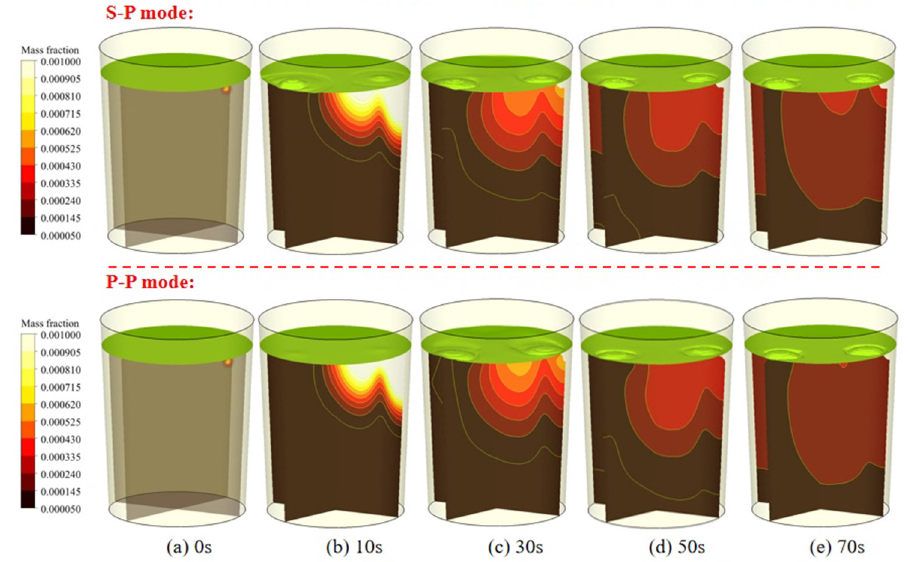
Figure 10. Mass fraction of dye tracers at di ff erent times with di ff erent modes: ( a ) 0 s, ( b ) 10 s, ( c ) 30 s, ( d ) 50 s, ( e ) 70 s.